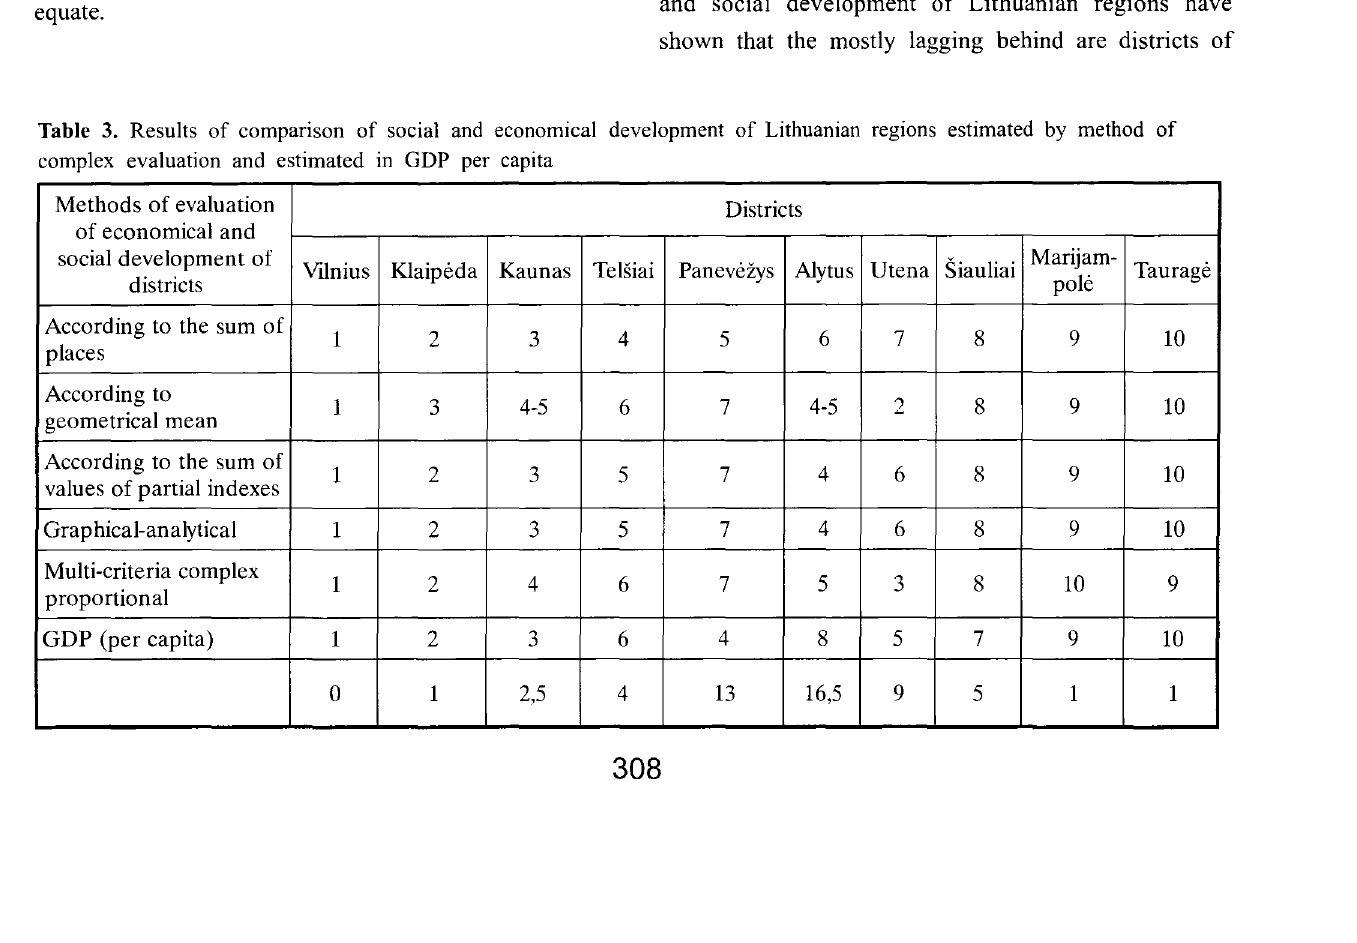
Fig 1. Graphical interpretation of results of comparison of social and economical development of Lithuanian regions estimated by method of complex evaluation and estimated in GDP per capita